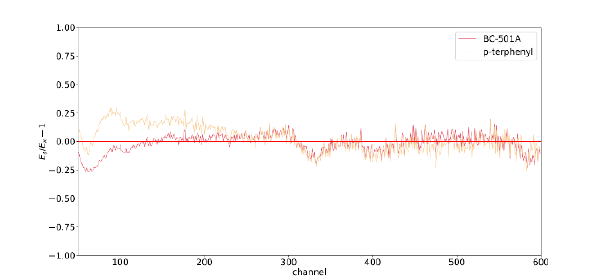
Fig. 10 E s /E x - 1 comparison of BC-501A and p-terphenyl with